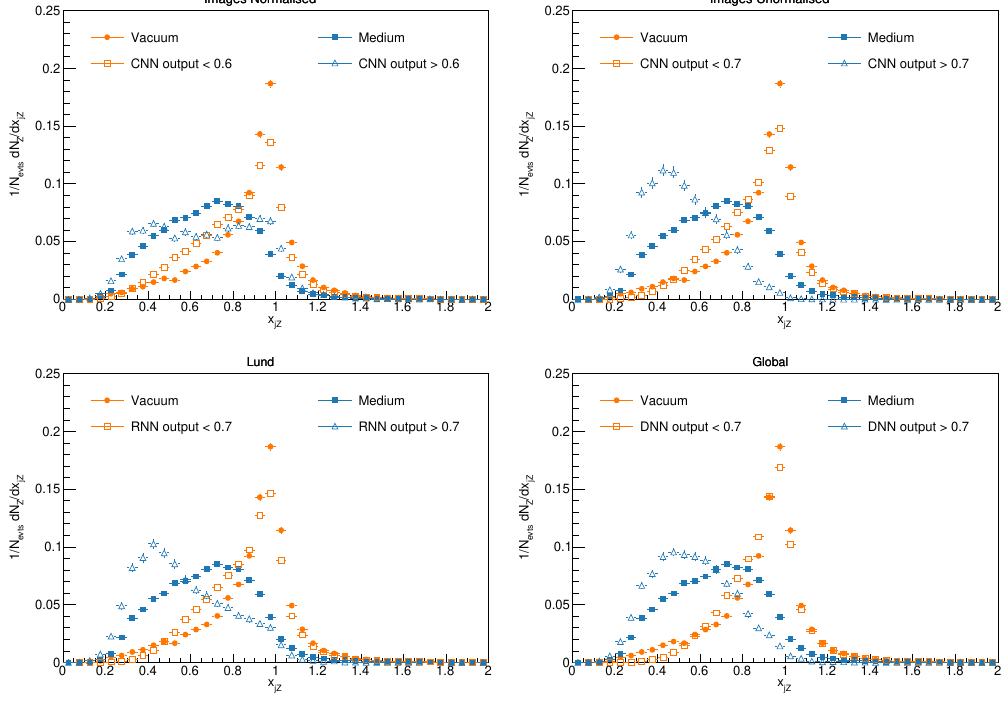
Figure 13 . Transverse momentum imbalance x jZ , for the different Deep Learning architectures. Monte Carlo truth from JEWEL+PYTHIA is provided in solid symbols for the Vacuum and Medium samples and a subset of events selected by the DL discriminant appears in open symbols. The DL output selection employed to identify vacuum-like jets (open blue) and medium-like jets (open orange) is made explicit in the legend of each